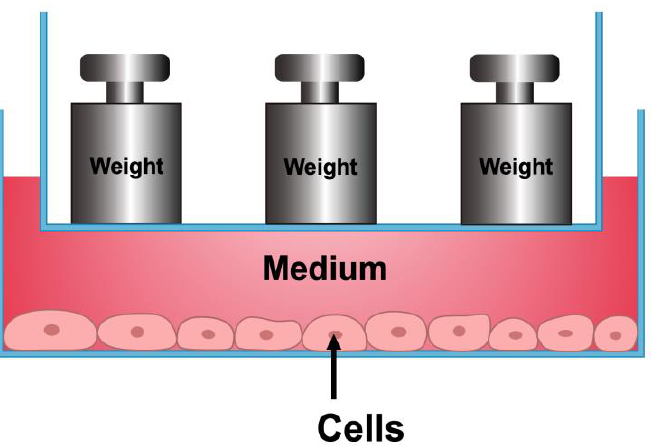
Figure 7. Schematic diagram showing the model used for hydrostatic compressive force. Weight ‘ship’ floats on the medium and compression force is applied to the cells in the form of hydrostatic